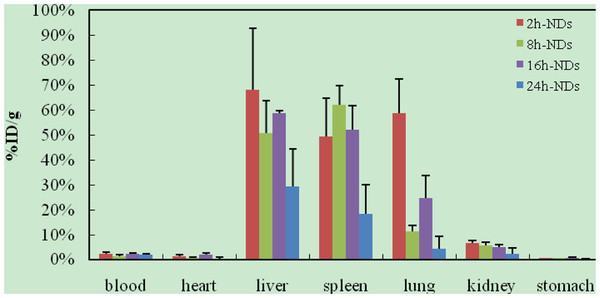
Biodistribution of NDs in mice at 2, 8, 16, and 24 h post i.v. with 99mTc-NDs.